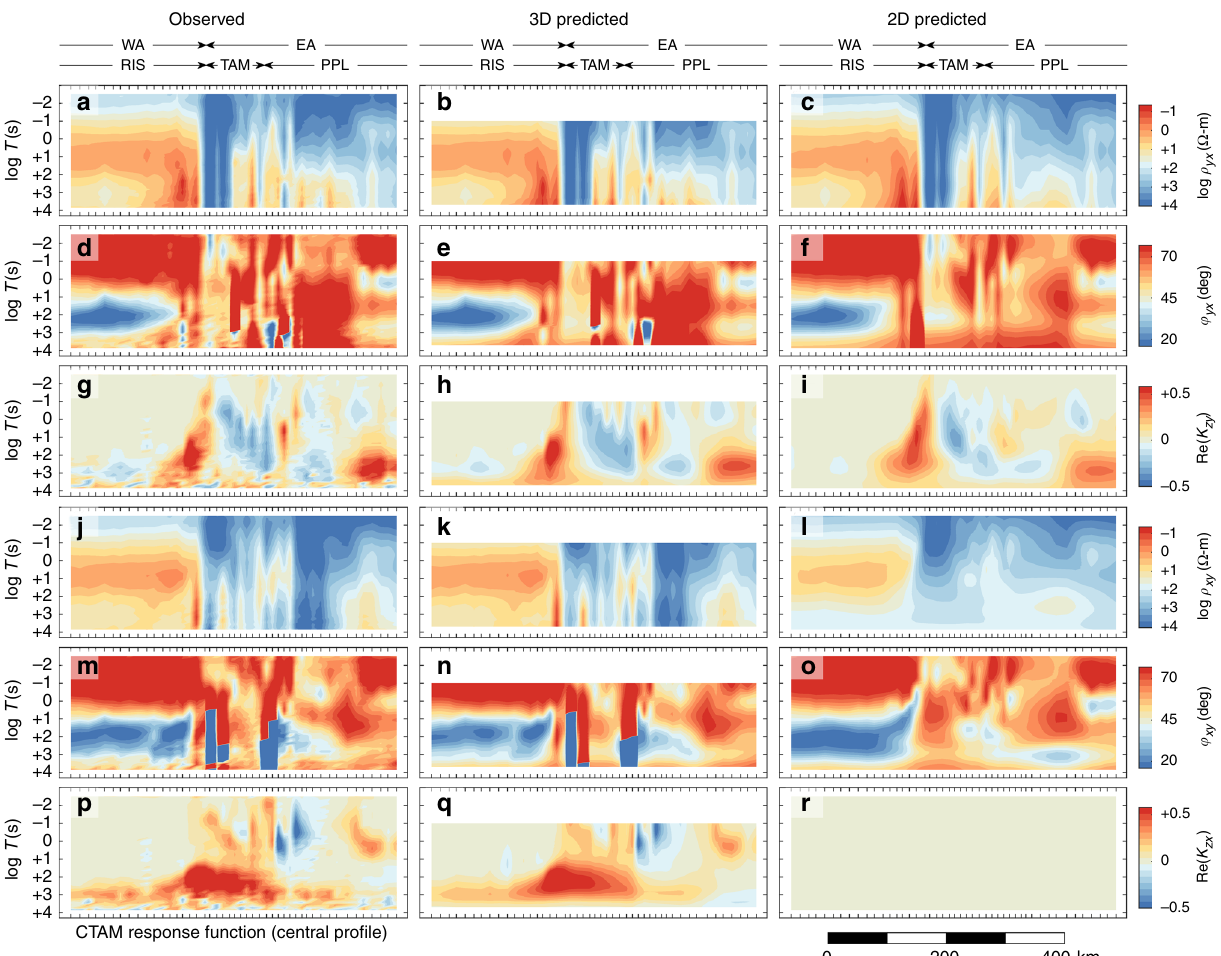
Fig. 4 Pseudosections of primary MT observations. These are plotted as a function of period ( T ) and distance, both observed and computed from inversion, for stations along the central pro fi le of Fig. 1. These include apparent resistivities ρ xy and ρ yx , and impedance phases φ xy and φ yx , from the off-diagonal impedance elements, and the real (in-phase) component of the complex tippers K zx and K zy . The x axis for data de fi nition is grid N315°. To ease fi nite element mesh discretization requirements, the 3D inversion only considered data for T > 0.1 s. Included for comparison with the 3D analysis is the calculated response of a purely 2D inversion model described in “ Methods ” with Supplementary Fig. 14. Physiographic regions are as in Fig. 2. An additional plot of Fig. 4 using a spectral color scheme is presented as Supplementary Fig.